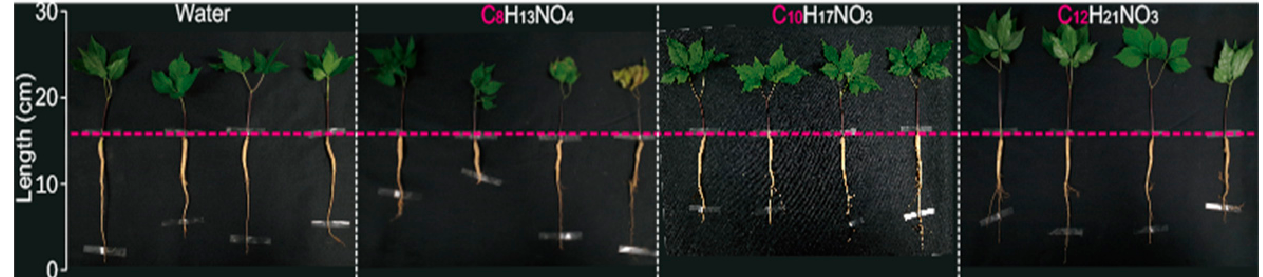
Figure 1. Effect of the treatment of the acyl-homoserine lactones (C8, C10, C12) on the growth of ginseng.